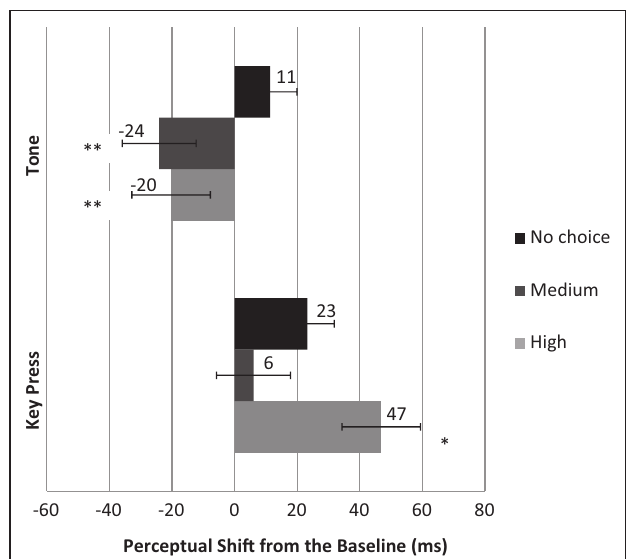
FIGURE 2 | Mean perceptual shift (difference between the judgment errors in the operant and baseline conditions) for key press (lower) and tone (upper) judgments. Error bars represent SEM (*indicates that the perceptual shift for key presses in the high level of choice condition was significantly greater than the medium level of choice and no choice conditions, p < .05. The difference between medium level of choice and no choice conditions was not significant, p > .05. **Indicates that the perceptual shift for the tone judgments in the high level of choice and the medium level of conditions were significantly greater than no choice condition, p < .05. The difference between high and medium levels of choice was not significant, p > .05).